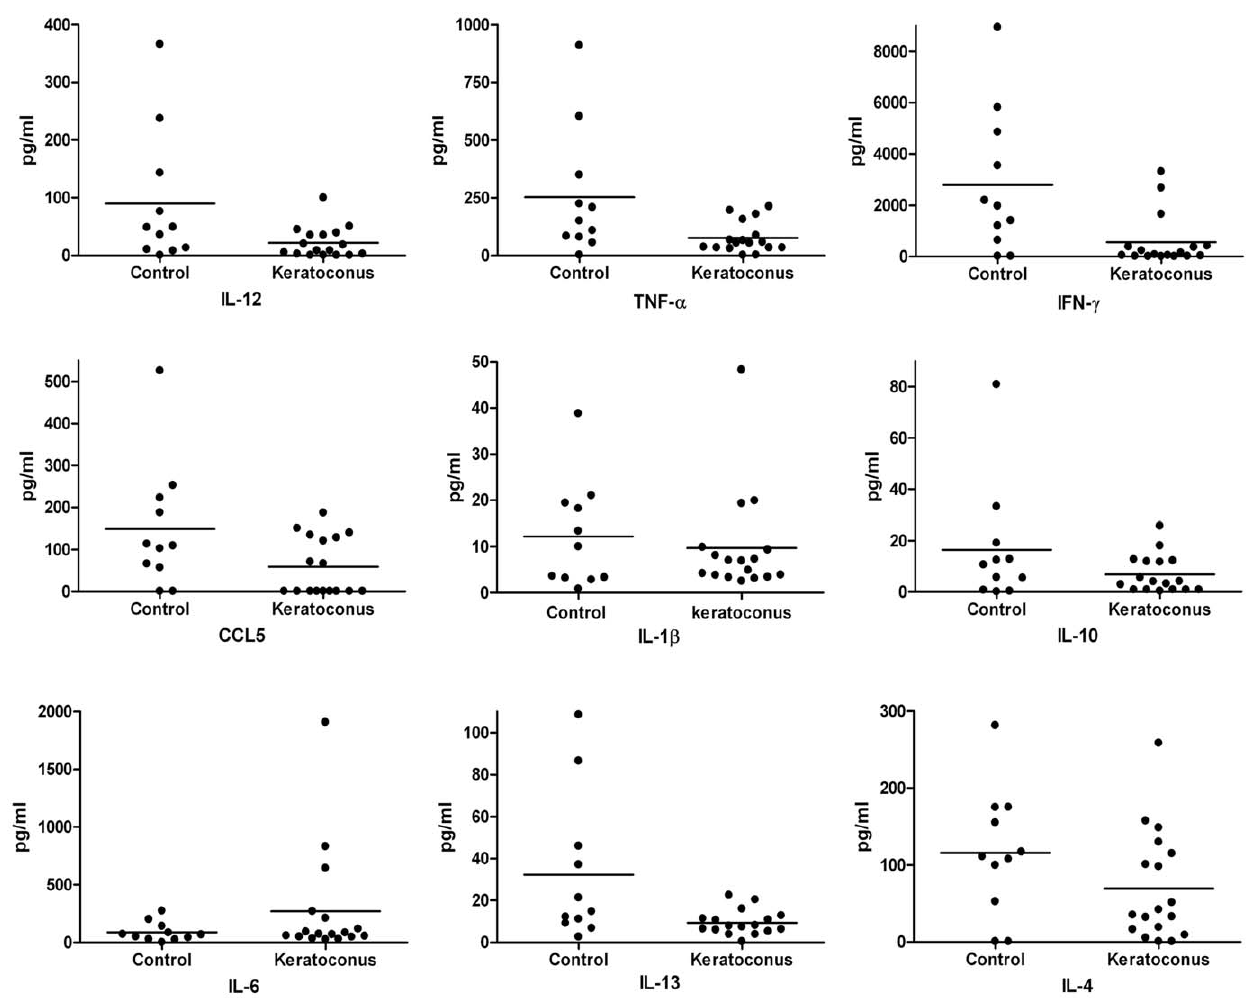
Figure 1. Cytokine measurements in tear fluids by a multiplex immuno-bead assay. Each cytokine was measured in individual subjects. The horizontal bar indicates the mean value for each group. After correcting for age and contact lens use, IL-12, TNF- a , and RANTES/CCL5 were significantly lower in KC than in controls. Statistical analyses of the data are shown in Tables 2 and 3.